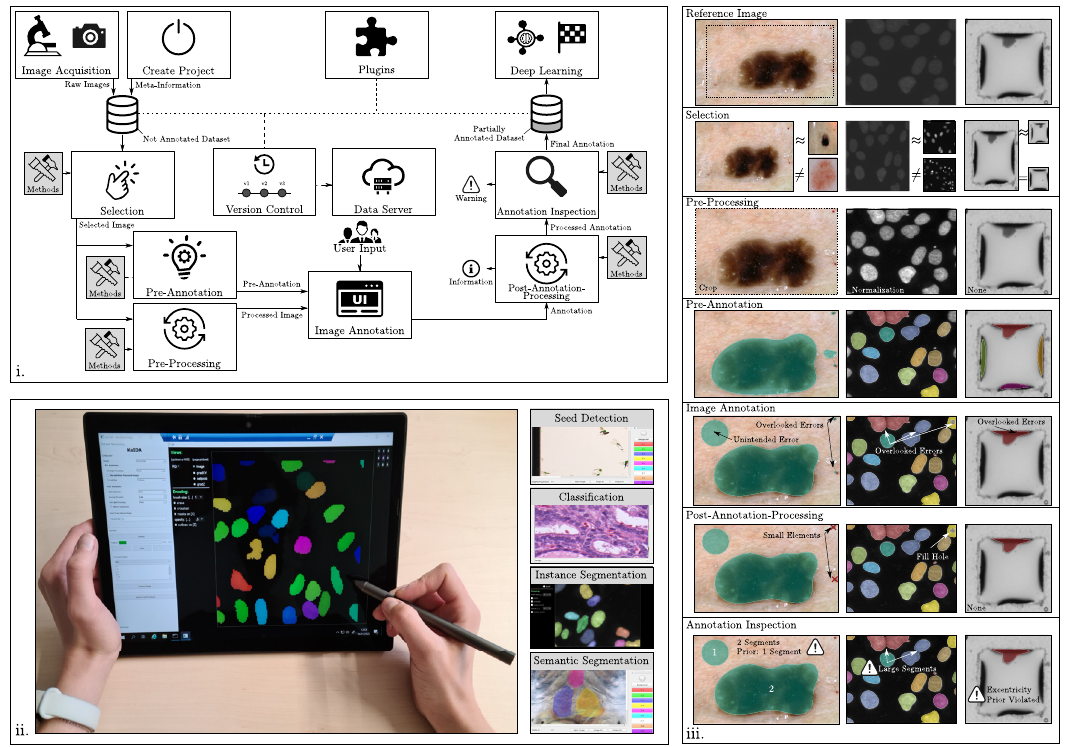
Figure 1: Overview KaIDA. The interaction of the individual modules is shown via an overview diagram. (ii) Application. A domain expert uses the tool KaIDA in the proposed setup (cf. Supplementary Information) for the annotation of images in the case of instance segmentation [3, 9]. In additioPopova2019FacileOneStepn, KaIDA supports seed detection, classification, and semantic segmentation [2, 4, 5]. (iii) Exemplary Results. Three reference images [3, 16, 17] are utilized to present the